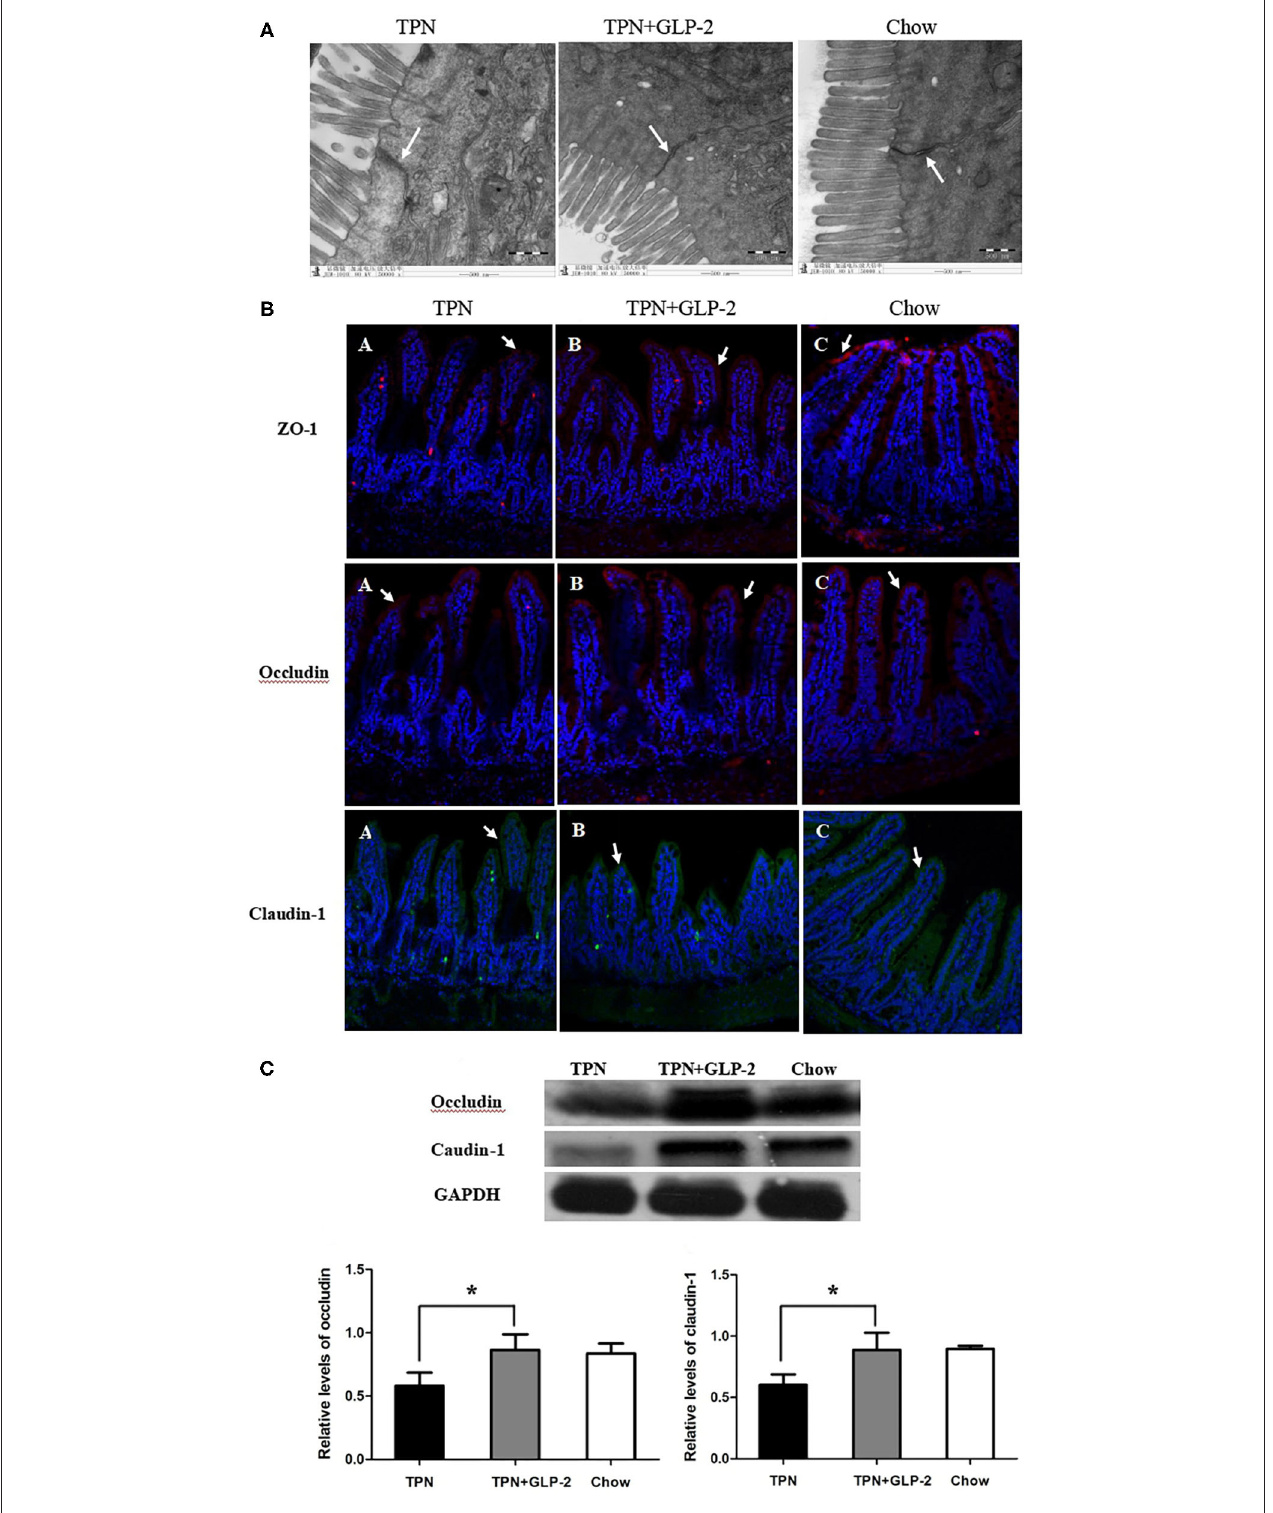
FIGURE 1 | The tight junctions and tight unction proteins. (A) Transmission electron microscopy. (B) Immunofluorescence. (C) Western blot analysis. Where *indicates P < 0.05 for TNP vs. TPN + GLP-2 and Chow.